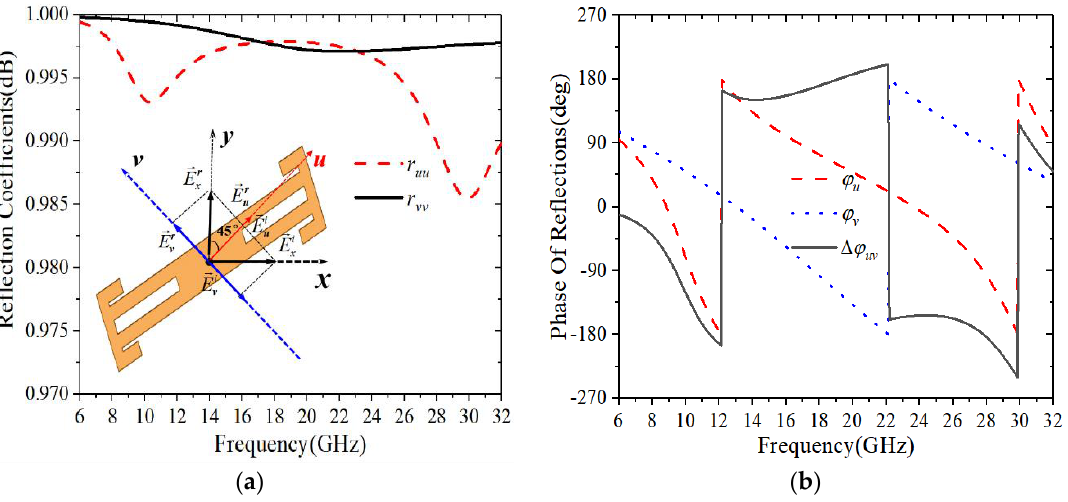
Figure 8. Simulated reflection coefficients of the proposed polarization converter under u - and v -polarized normal incidences. ( a ) Amplitude; ( b ) Phase.